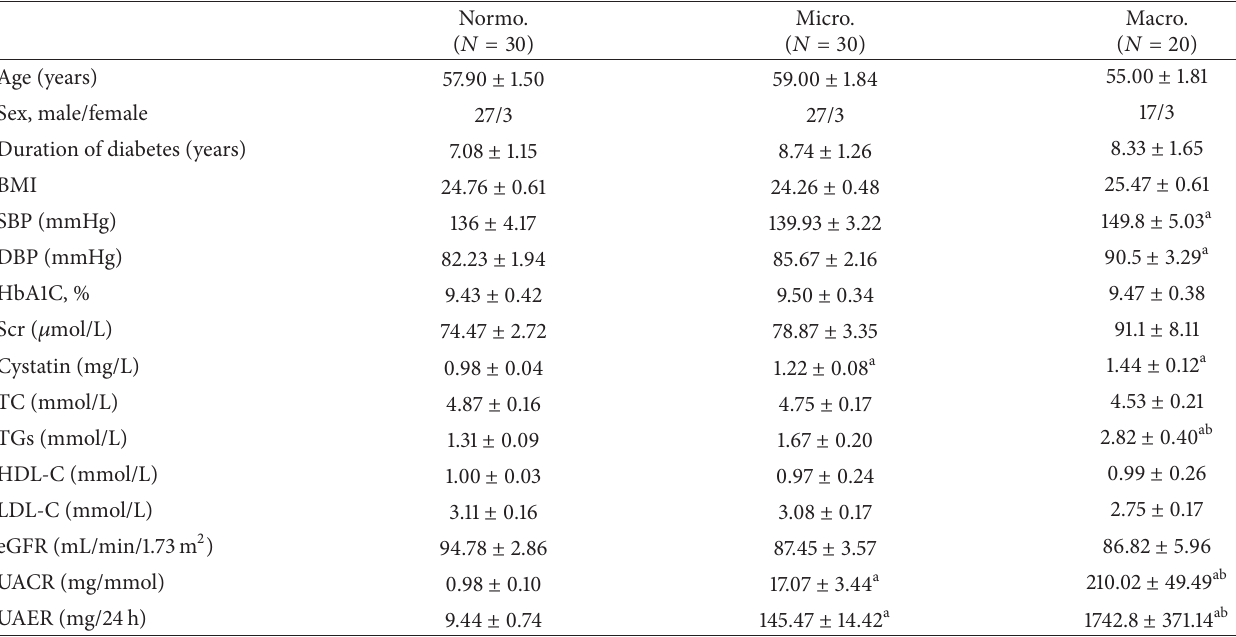
Table 1: Demographic characteristics of subjects.